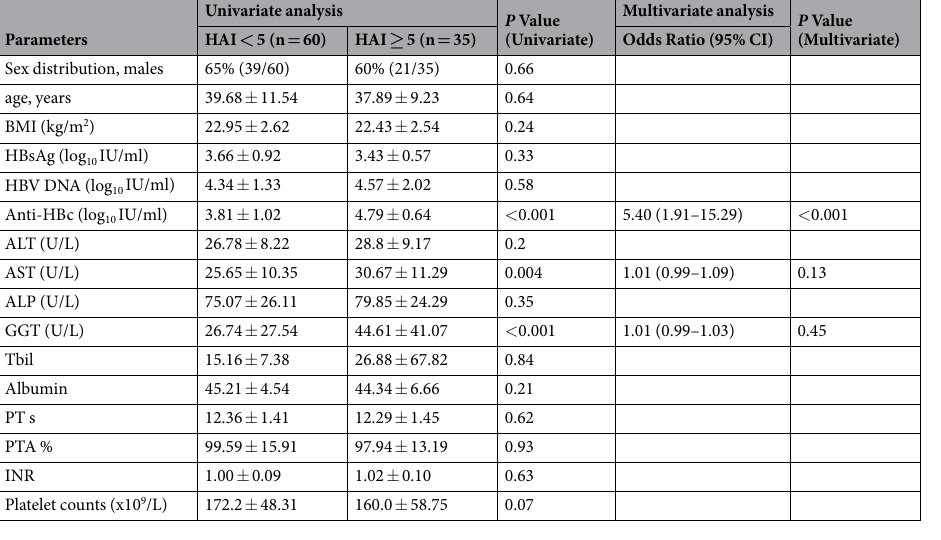
Table 4. Univariate and multivariate analysis of clinical parameters, cytokines with histological activity index in HBeAg ( − ) patients with normal ALT levels (n = 95). MBI, body mass index; HBsAg, hepatitis B surface antigen; HBeAg, hepatitis B e antigen; anti-HBc, hepatitis B core antibody; ALT, alanine aminotransferase; AST, aspartate aminotransferase; ALP, alkaline phosphatase; GGT, gamma-glutamyl transpeptidase; Tbil, total bilirubin; PT, prothrombin time; PTA, prothrombin time activity; INR, international normalized